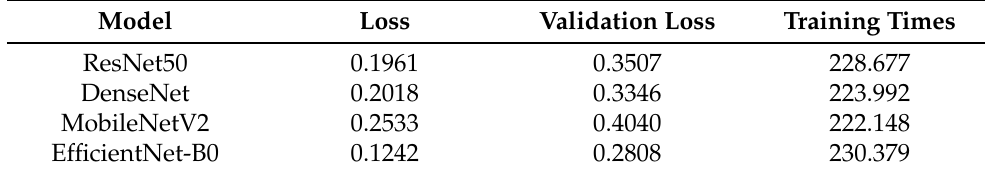
Figure 9. The comparison of loss and validation loss from ResNet50, DenseNet, MobileNetV2, and EfficientNet-B0. Table 2. Comparison of loss and validation loss for all